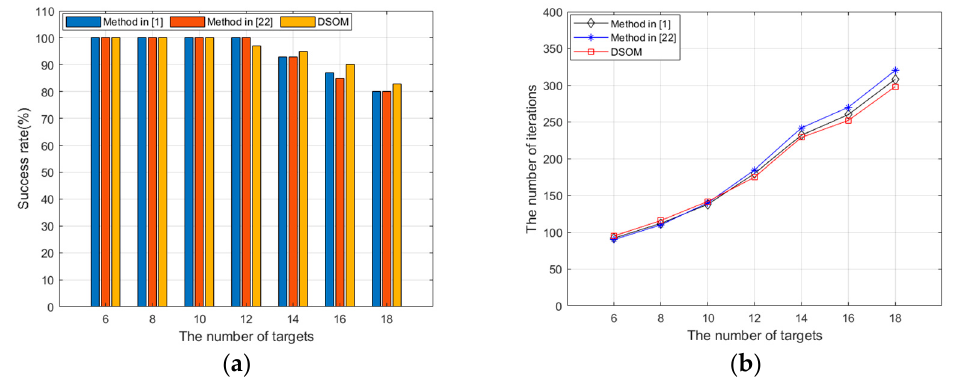
Figure 9. The influence of the number of targets. ( a ) The influence of the number of targets on the success rate, ( b ) the influence of the number of targets on the number of iterations .